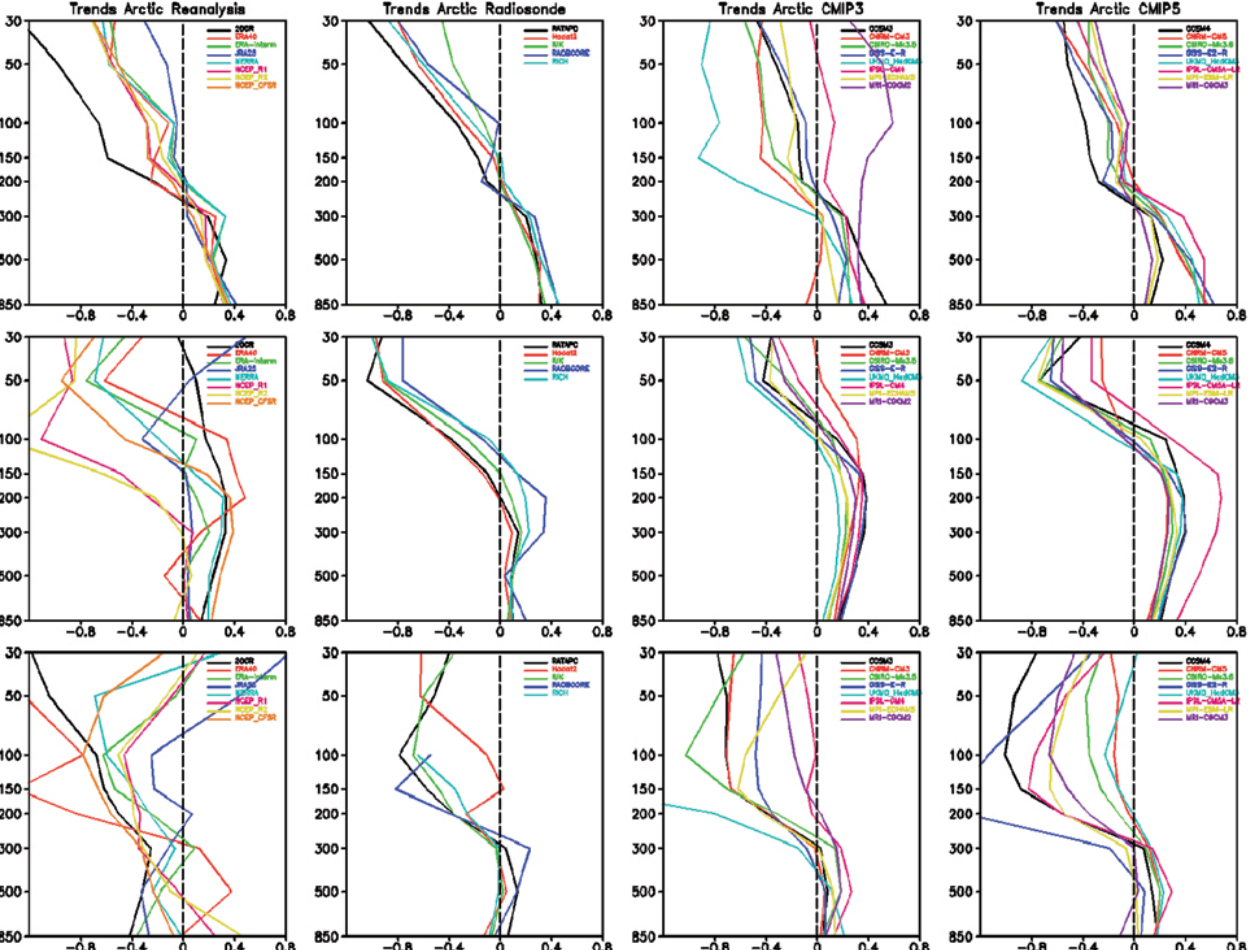
Fig. 4. Vertical profiles of the trends ( ◦ Cdecade − 1 ) for the Arctic, tropic and Antarctic temperature from 1979 through 2005. Arctic: (a) radiosonde, (b) reanalysis, (c) CMIP3 and (d) CMIP5; tropics: (e) radiosonde, (f) reanalysis, (g) CMIP3 and (h) CMIP5; Antarctic: (i) radiosonde, (j) reanalysis, (k) CMIP3 and (l)